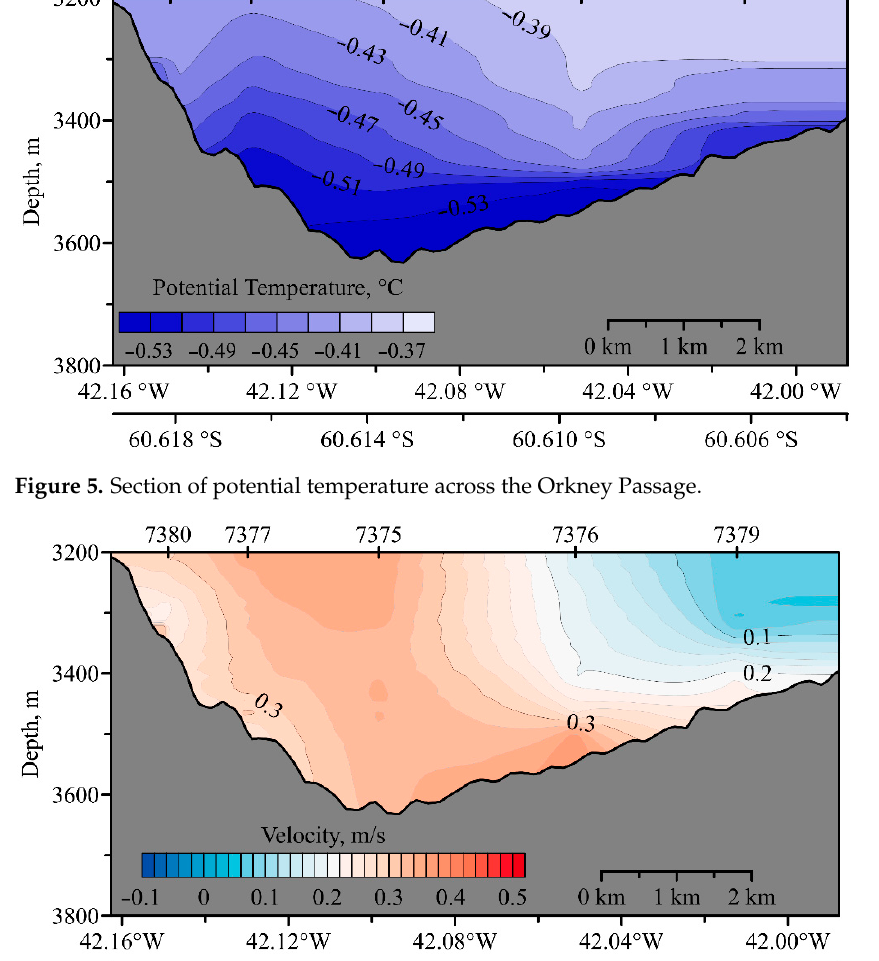
Figure 5. Section of potential temperature across the Orkney Passage.